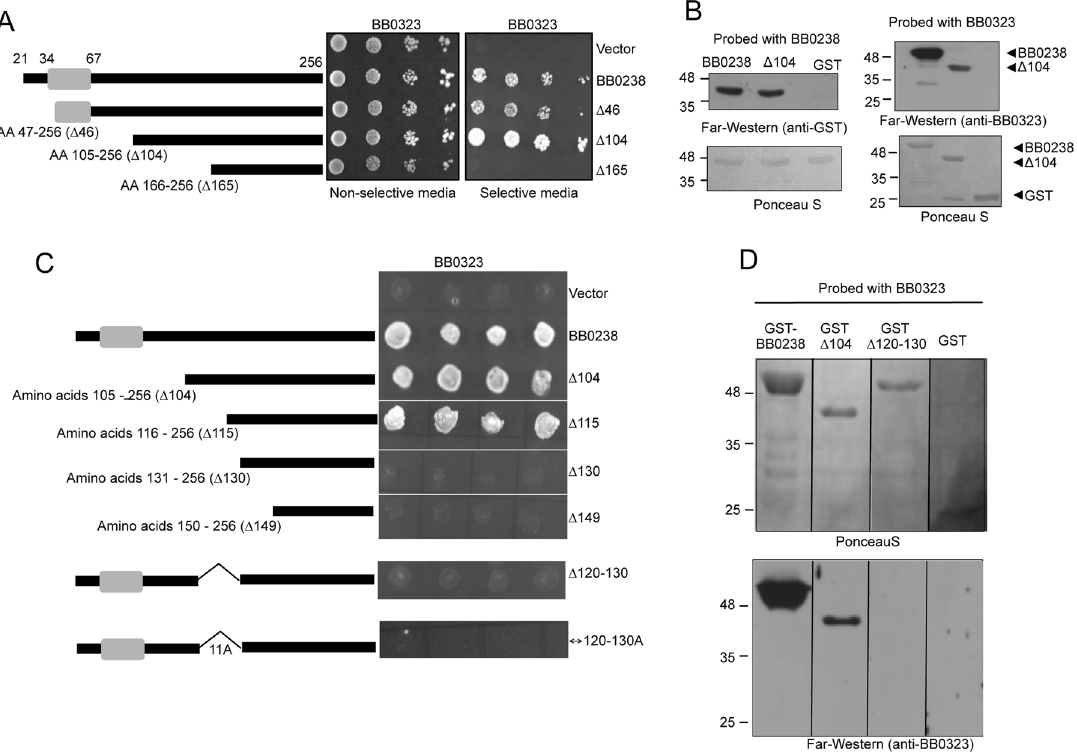
Figure 1. Probing the BB0238-BB0323 interaction. ( A ) Residues 34–67 in BB0238 are not involved in the interaction with BB0323. Yeast two-hybrid assays for assessment of BB0238-BB0323 interaction. The yeast vector pGAD expressing GAL4 activation domain (AD) or various fusions of AD-BB0238 were introduced into yeast along with the vector pGBKT7 expressing the GAL4 DNA binding domain (BD) fused with BB0323. Serially diluted transformants were grown in non-selective (SD-Trp-Leu) or selective (SD–Ade–His–Leu–Trp) media and yeast growth was recorded. ( B ) BB0323 and BB0238 interact in Far-Western assays. Recombinant BB0323 (left panels) or BB0238 (right panels) was subjected to SDS-PAGE and incubated with glutathione S-transferase (GST)-fused BB0238, or His-tagged BB0323 proteins, and binding was examined by appropriate primary and secondary detection antibodies. ( C ) Residues 120–130 of BB0238 mediate the interaction with BB0323. Yeast vector expressing indicated AD-BB0238 fusion proteins were cotransformed with BD-BB0323 and growth was assessed, as detailed in panel A. ( D ) BB0238 missing 11-residue interaction motif failed to bind BB0323 in far-Western assays. Recombinant GST-BB0238 fusion proteins were subjected to SDS-PAGE and incubated with recombinant his-tagged BB0323 and the interaction was monitored as described in panel B. Migration of protein standards is shown to the left in